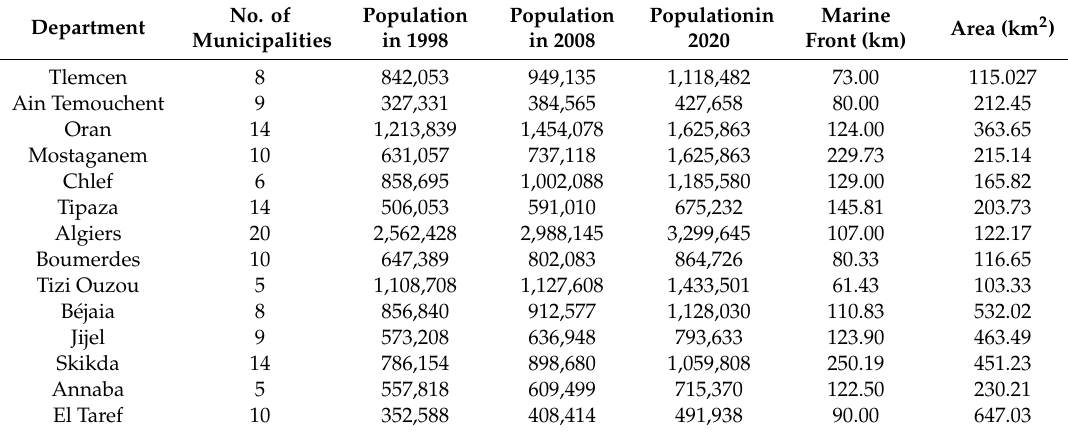
Table 3. Area and number of the population of the coastal departments. Source of data: National Statistics O ffi ce of Algeria. Data comes from the three national censuses in 1998, 2008, and 2020.